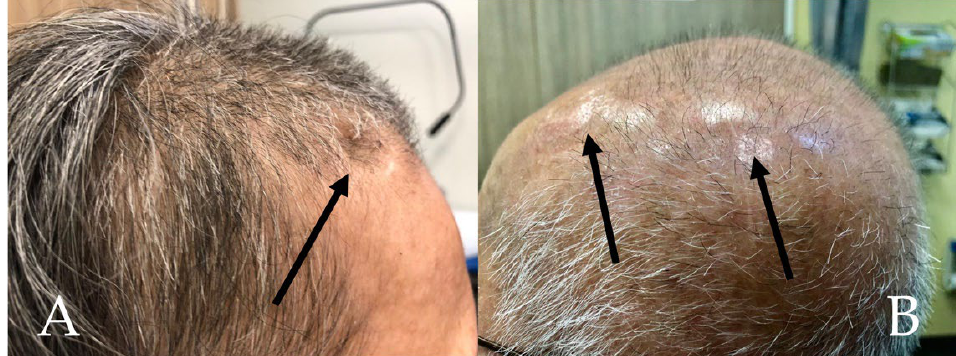
Figure 2. ( A ) A clinical photograph of the burrhole depression (black arrow) of a right frontal burrhole after a burrhole craniostomy where no burrhole cover was used. ( B ) A clinical photograph of a patient who received Design 2 in the left parietal burrhole (posterior arrow) and Design 1 in the frontal burrhole (anterior arrow), showing a good cosmetic outcome.